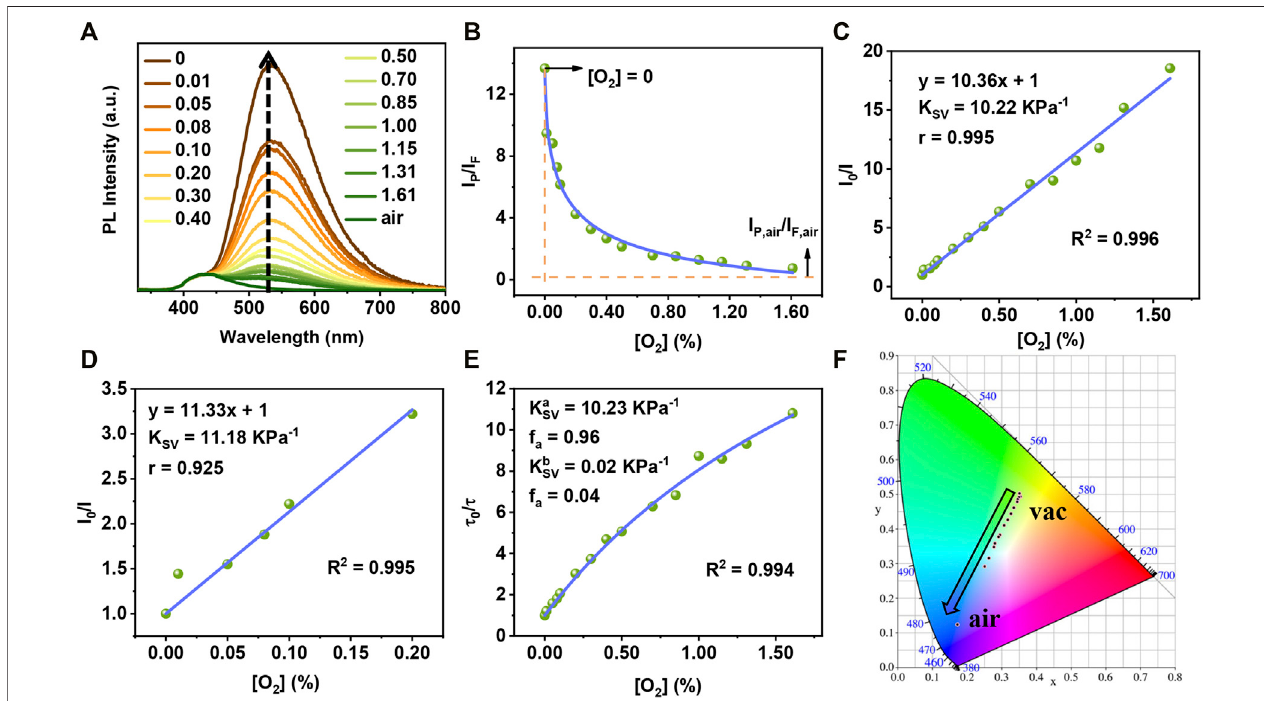
FIGURE2| (A) Emission spectra ofTA2P-PMMA fi lmat differentoxygenconcentrations (excited by300 nm). (B) The plotof I P / I F against oxygenconcentration for TA2P PMMA fi lm. (C) Stern – Volmer curve of TA2PPMMA fi lm based on the emission spectrum method ( fi tting range: 0% – 1.61%). (D) The Stern – Volmer curveofTA2P PMMA fi lm based on the emission spectrum method ( fi tting range: 0% – 0.20%). (E) the “ Demas model ” curve of TA2P PMMA fi lm based on the lifetime method. (F) The Commission Internationale del ’ Eclairage (CIE) coordinates of TA2P PMMA fi lm with varying oxygen